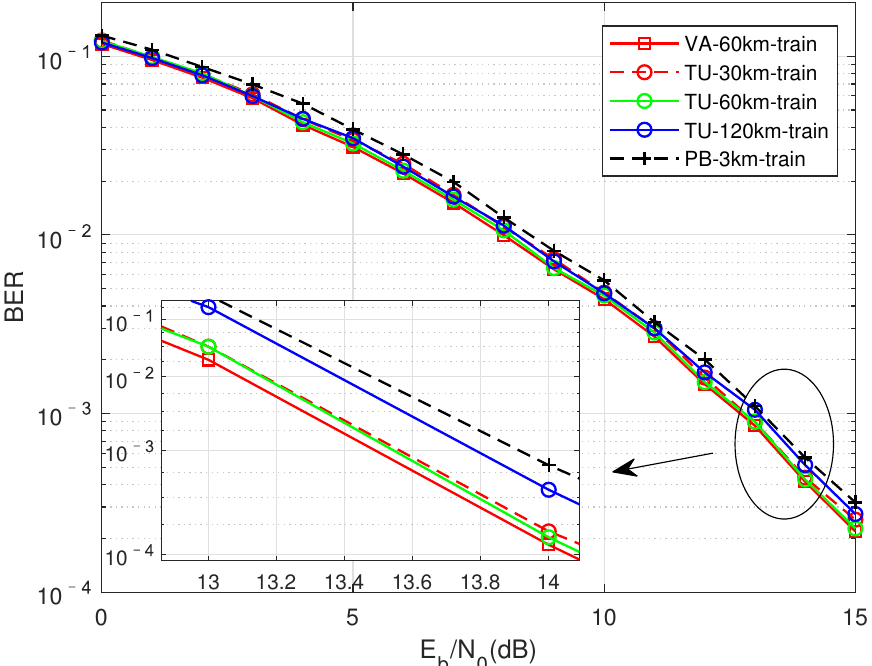
Figure 10. Perform training in different channel environments under the condition of matching signal-to- noise ratio, test with VA-60 km/h, performance under the condition of compression factor τ =